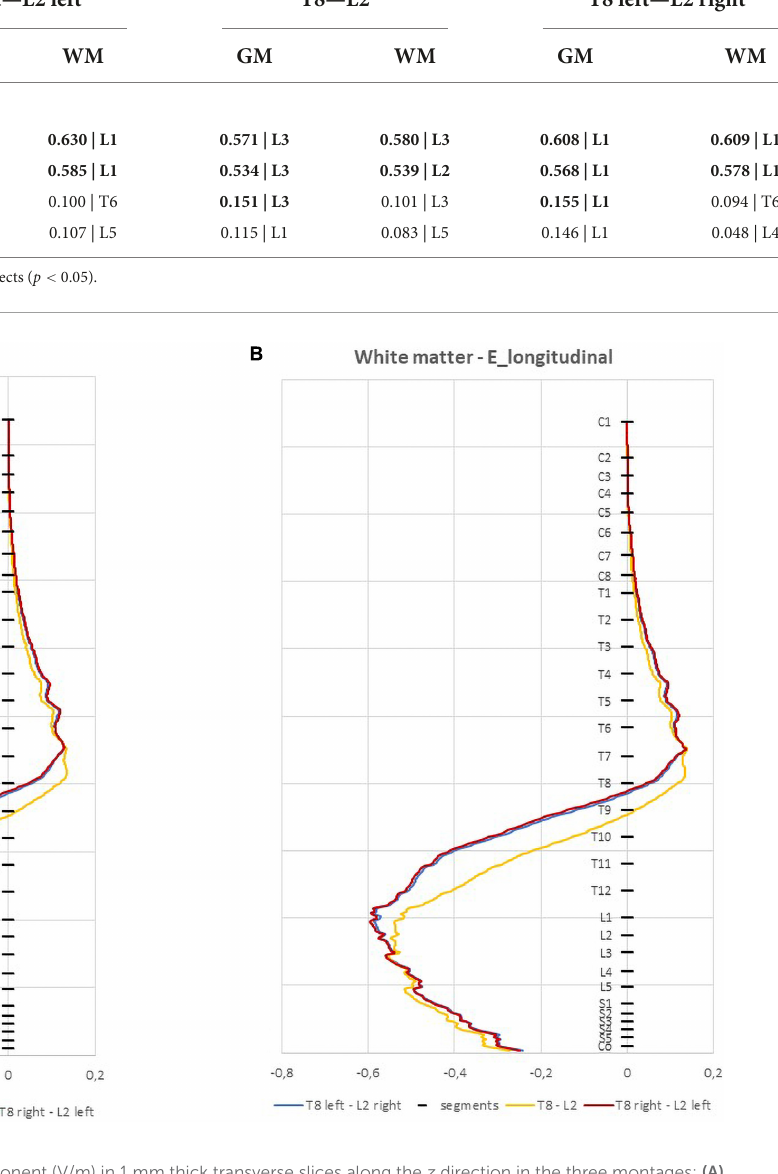
TABLE 2 Maximum values of the E norm and components E long , E vd , and E rl and corresponding spinal segments in spinal gray matter (spinal-GM) and WM for the 3 montages ( I = 4 mA). Average values T8 right—L2 left T8—L2 T8 left—L2 right